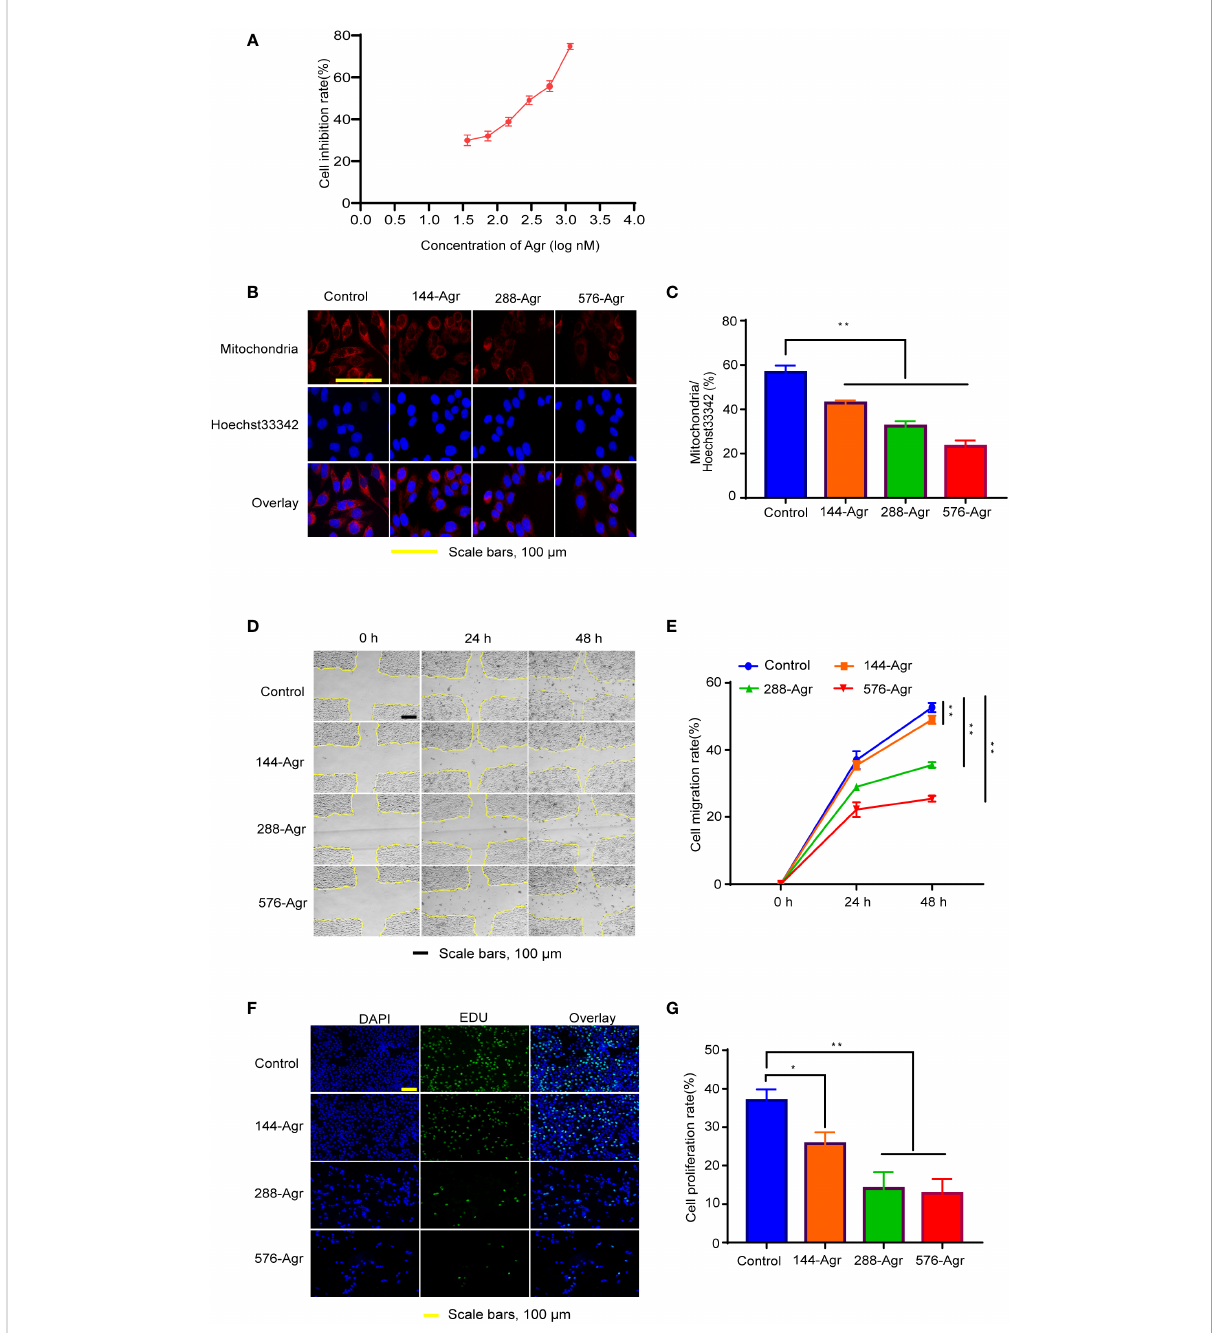
FIGURE 1 Agr inhibits HCT116 cell proliferation and invasion by modulating mitochondrial functions. (A) Cytotoxicity of Agr (36, 72, 144, 288, 576, and 1,152 nM) against HCT116 cells using the MTT assay. (B) Confocal fl uorescence images of HCT116 cells with mitochondrion/Hoechst 33342 double staining. Cell mitochondria stained with MitoTracker Deep Red FM showed a red fl uorescence signal; Hoechst 33342-labeled nuclei showed a blue fl uorescence signal. (C) The proportion of cells with mitochondrial dysfunction in HCT116 cells after treatment with different Agr concentrations. (D) Representative photographs of the wound-healing assay. (E) HCT116 cell migration rate after treatment with different Agr concentrations. (F) The effects of Agr on HCT116 cell proliferation were measured via EdU staining; nuclei in blue (DAPI) and daughter cells in green (EDU). (G) HCT116 cell proliferation rate after different Agr treatments. The data processing was shown as mean ± SD ( n = 3, each group). ** p < 0.01, * p < 0.05 vs. control. Scale bars = 100 m m. Agr, agrimol B; PGC-1 a , peroxisome proliferator-activated receptor- g coactivator 1 a